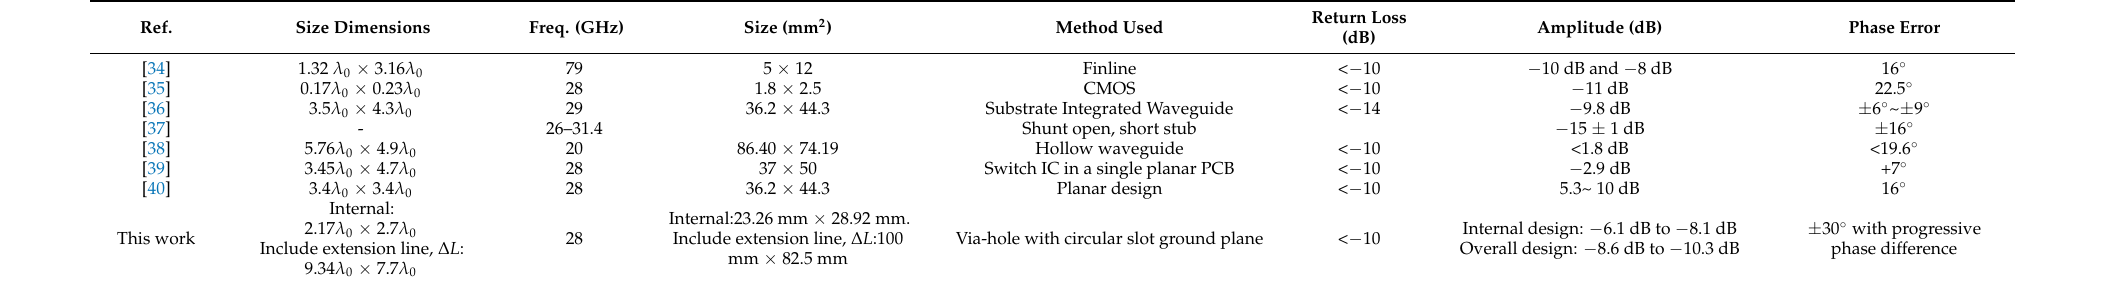
Table 5. A comparison with existing mmWave